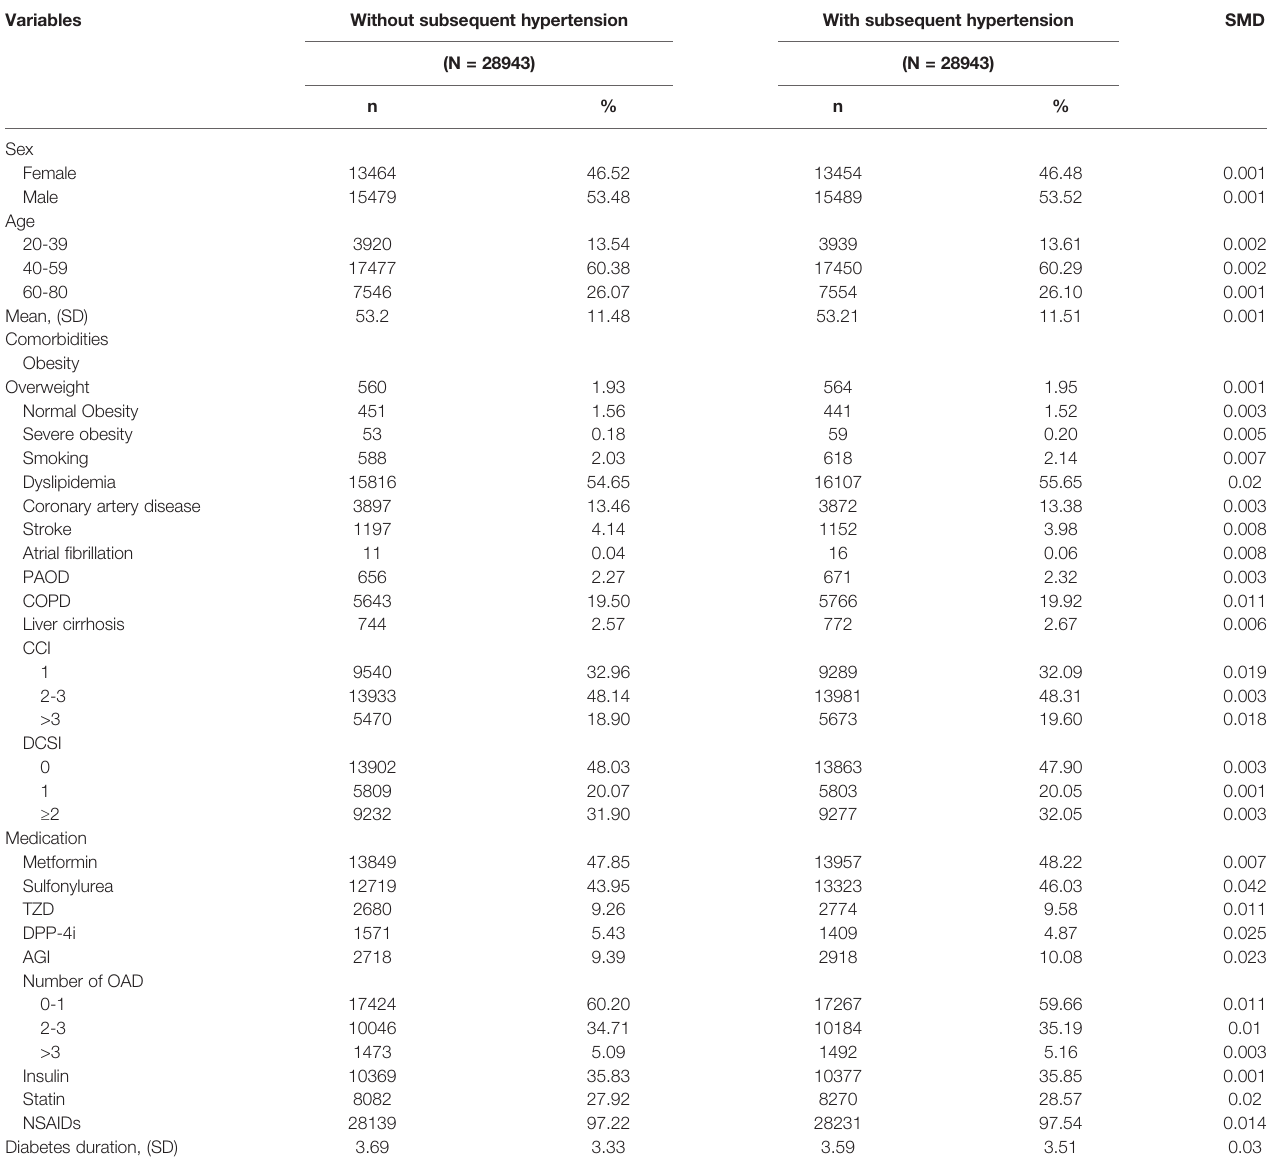
TABLE 1 | Comparison of baseline characteristics of the study subjects in the diabetes cohort. Variables Without subsequent hypertension With subsequent hypertension SMD (N = 28943)